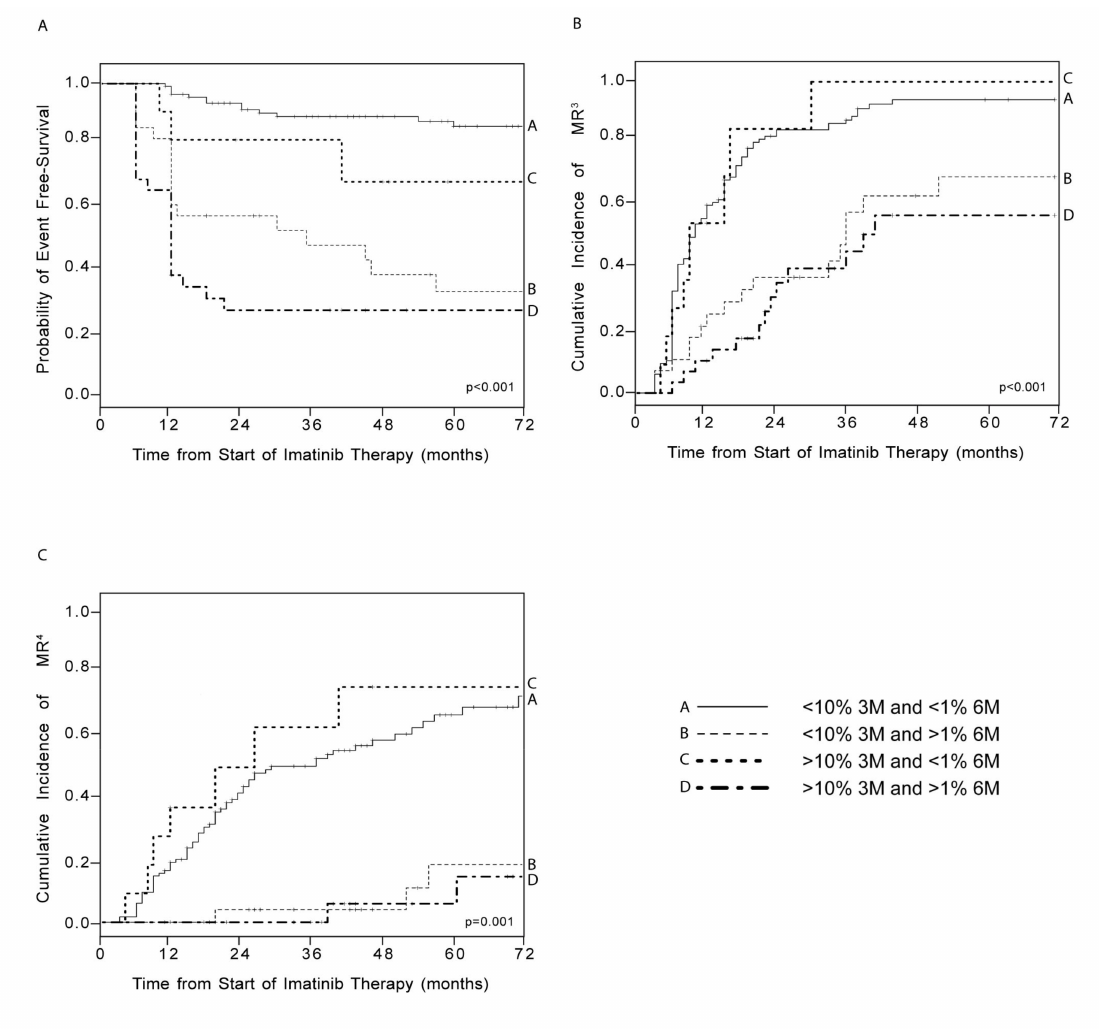
Figure 1. Event-free survival (EFS) estimates ( A ) and cumulative incidence of major molecular response (MR 3 ) ( B ) and deep molecular response (MR 4 ) ( C ) according to BCR - ABL1 / ABL1 IS transcripts at 3 and 6 months. Patients were divided into four groups according to their BCR - ABL1 expression at the 3 and 6 months. EFS probability ( A ) and cumulative incidence of MR 3 ( B ) and MR 4 ( C ) were calculated for each group. Vertical lines indicate censored patients. p -values refer to statistical significance among all four groups included in the